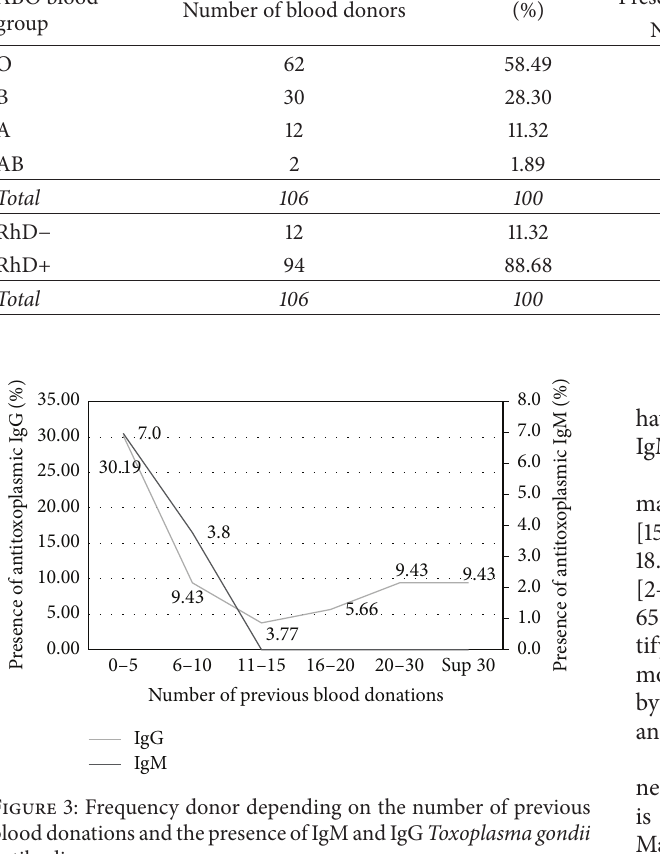
Table 3: Distribution of donors according to the ABO-Rh and the presence of IgM and IgG Toxoplasma gondii antibodies. ABO blood group